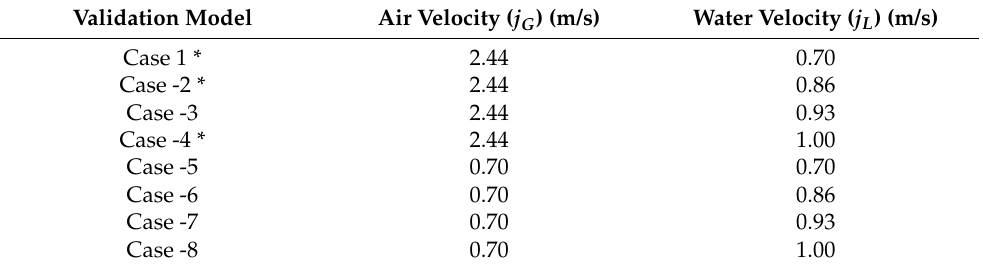
Table 2. Cases for the quantitative validation of CFD model.